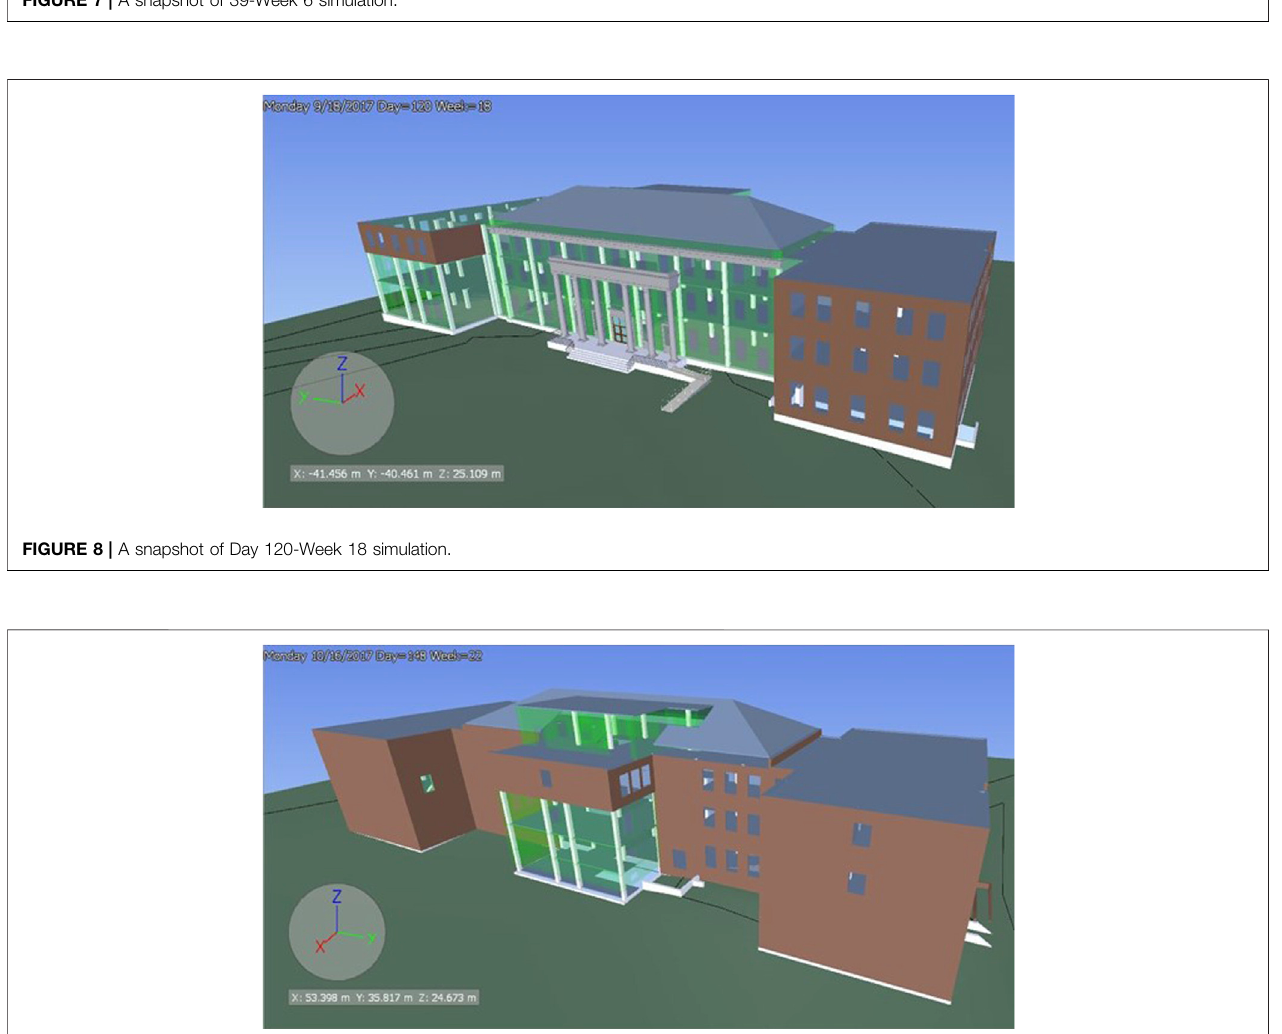
FIGURE 9 | A snapshot of Day 148-Week 22